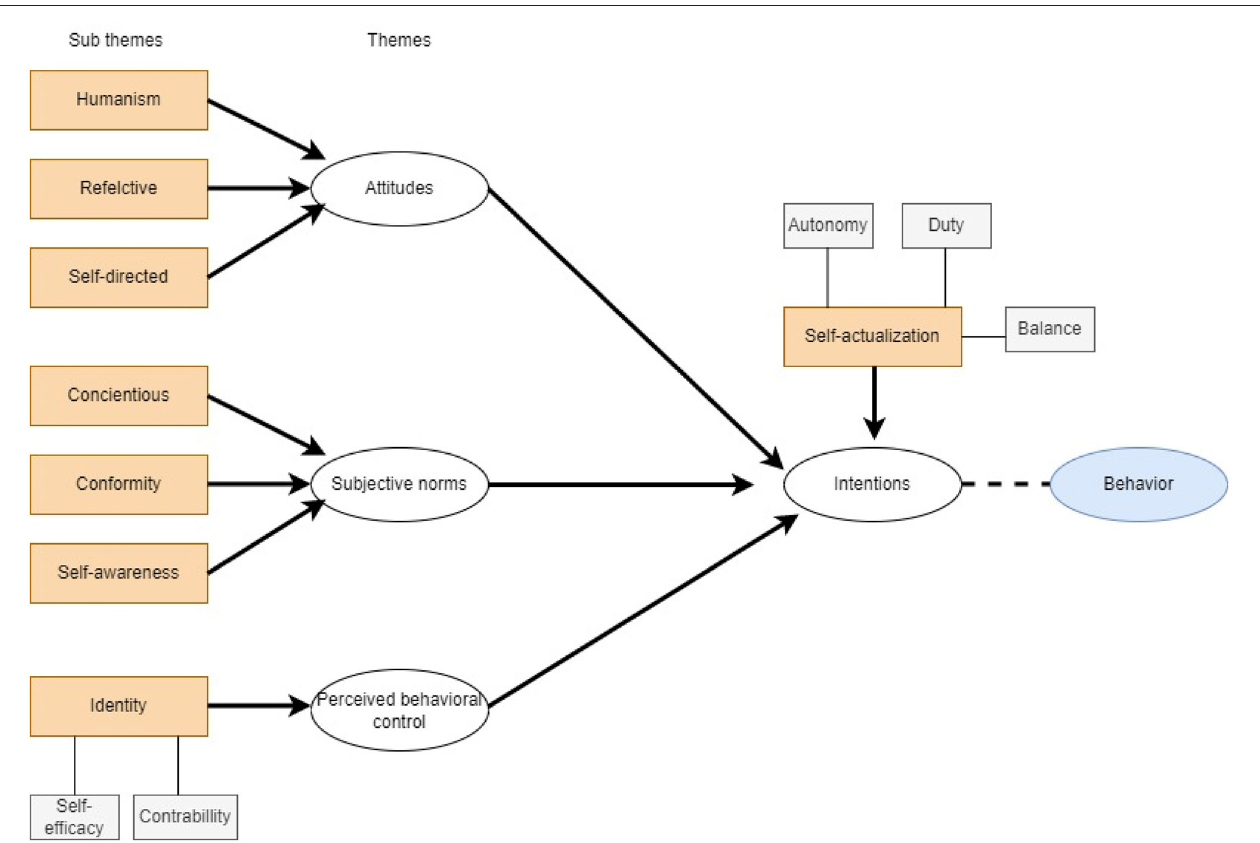
FIGURE 4 | The process of thematic analysis of the qualitative data which depicts relationship of subthemes and themes. All themes essentially lead to possible change in an individual’s behavior.